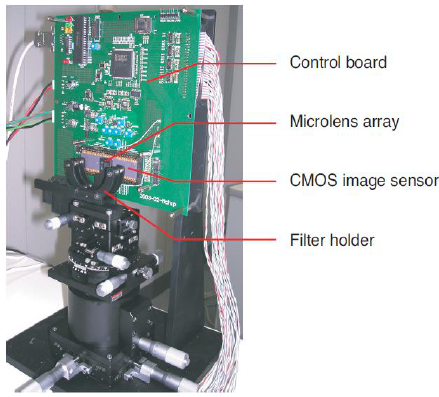
Figure 12. Filter characteristics.